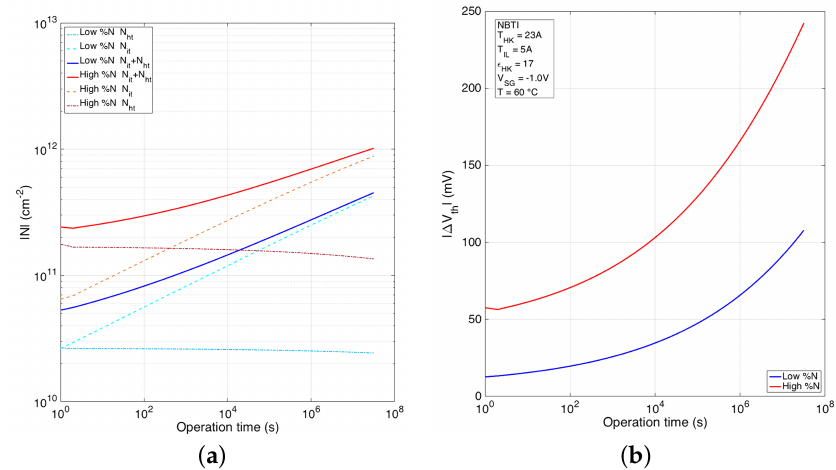
Figure 7. Components that constitute the NBTI phenomenon under different operation conditions. ( a ) Interface trap generation ( N it ), hole trapping ( N ht ), and the sum of both N it and N ht components, and ( b ) the absolute threshold voltage change.